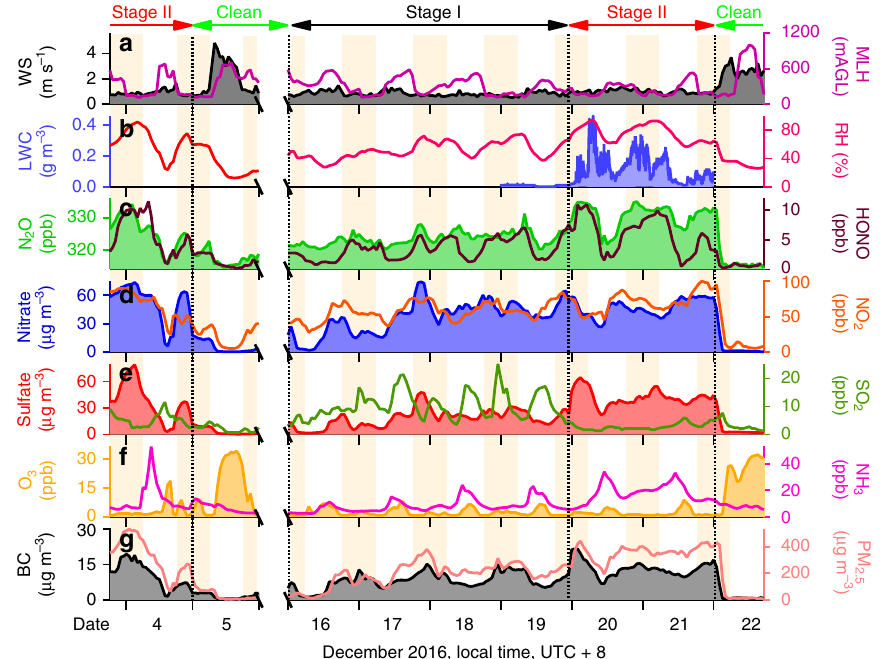
Fig. 1 Chronology of a winter haze event. The fi gure shows the time series of meteorological parameters and chemical species measured in Beijing on December 4 – 22, 2016. The measurements were made from the roof of an Institute of Atmospheric Physics (IAP) building except for liquid water content (LWC) measured at the Beijing Observatory of the China Meteorological Administration 20 km to the southeast, and PM 2.5 concentration measured at the Beijing Olympic Center Observatory 4 km to the northeast. UTC + 8 denotes Coordinated Universal Time + 8 h and represents local solar time in hours. a 10-m wind speed (WS) and mixing layer height (MLH) above ground level (AGL). b LWC and relative humidity (RH); c N 2 O and HONO concentrations; d PM 1 nitrate and NO 2 concentrations; e PM 1 sulfate and SO 2 concentrations; f ozone (O 3 ) and ammonia (NH 3 ) concentrations; and g black carbon (BC) and PM 2.5 concentrations. The campaign sampled the tail end of a haze event on December 4, terminated by passage of a cold front on December 5 and followed by variable conditions on December 6 – 15 (not shown, note break in time axis). It then sampled an extended pollution episode on December 16 – 22 with initially moderate RH of 40 – 75% (Stage I), followed by high RH (>75%) including dense nighttime fog at the Beijing Observatory (Stage II), and ending on December 22 with the passage of a cold front. Nighttime periods are shaded. Sulfate and nitrate measurements are from the HR-AMS instrument with a size cut of 1- μ m diameter (see text). can be expressed stoichiometrically as follows 28,29 :